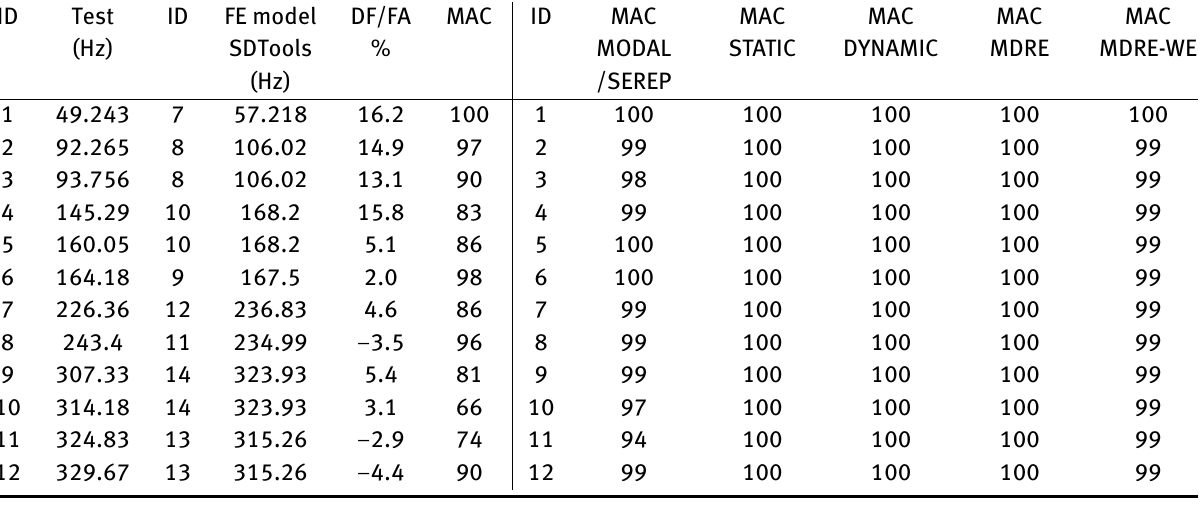
Table 2: Comparative MAC: Updated full model (SDTools) and MSE results vs. experimental measurements.